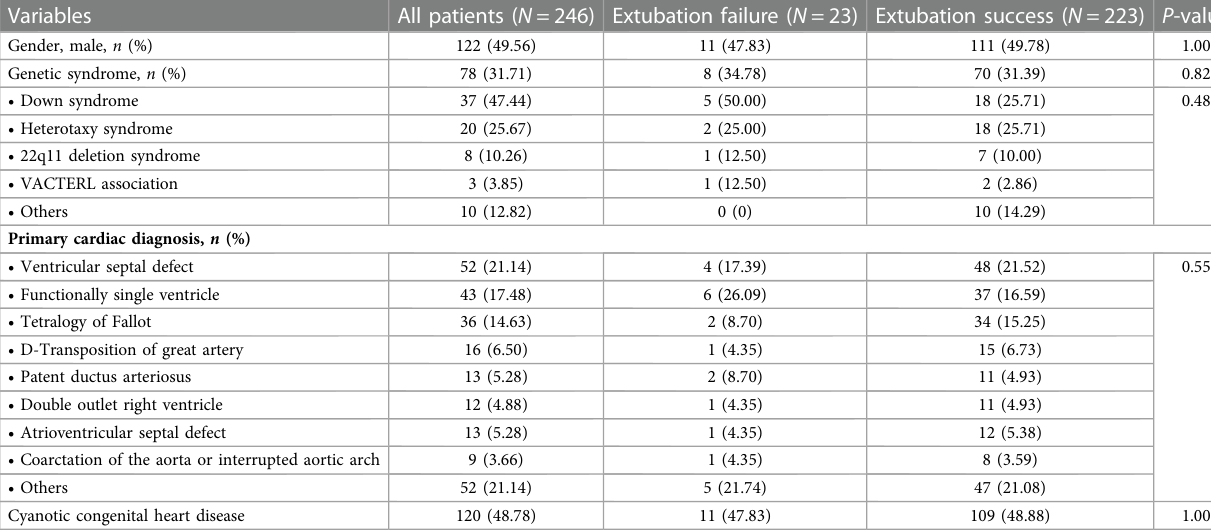
TABLE 1 Baseline demographic and clinical data of all included patients at baseline of fi rst extubation trial.